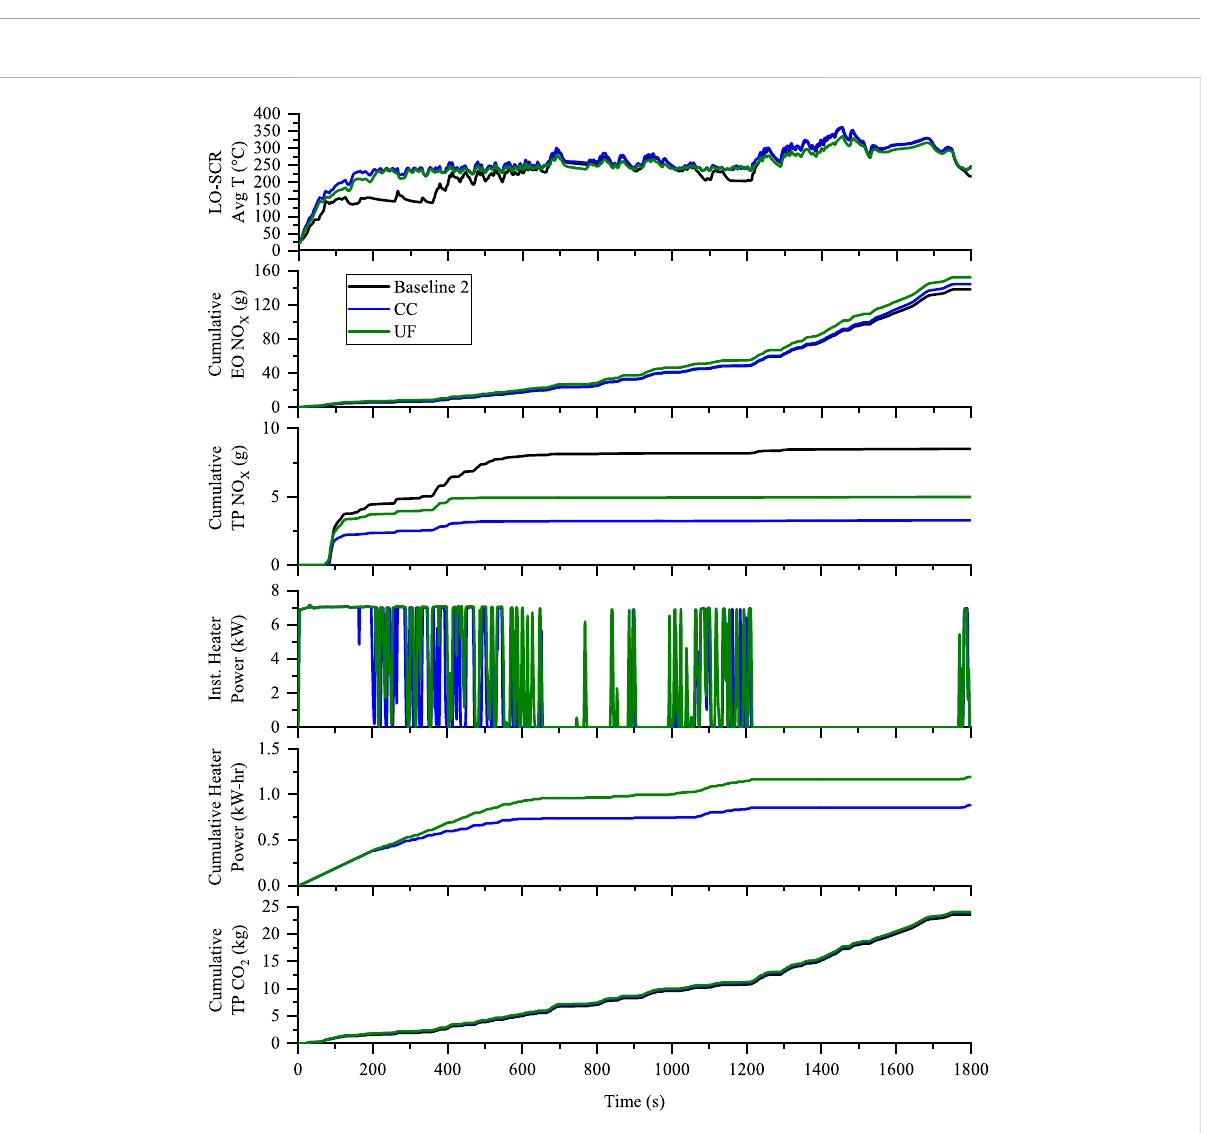
FIGURE 12 Comparison of the CC LO-SCR and UF LO-SCR to Baseline 2 on the cold WHTC for the LO-SCR average temperature, emissions, and heater electrical power